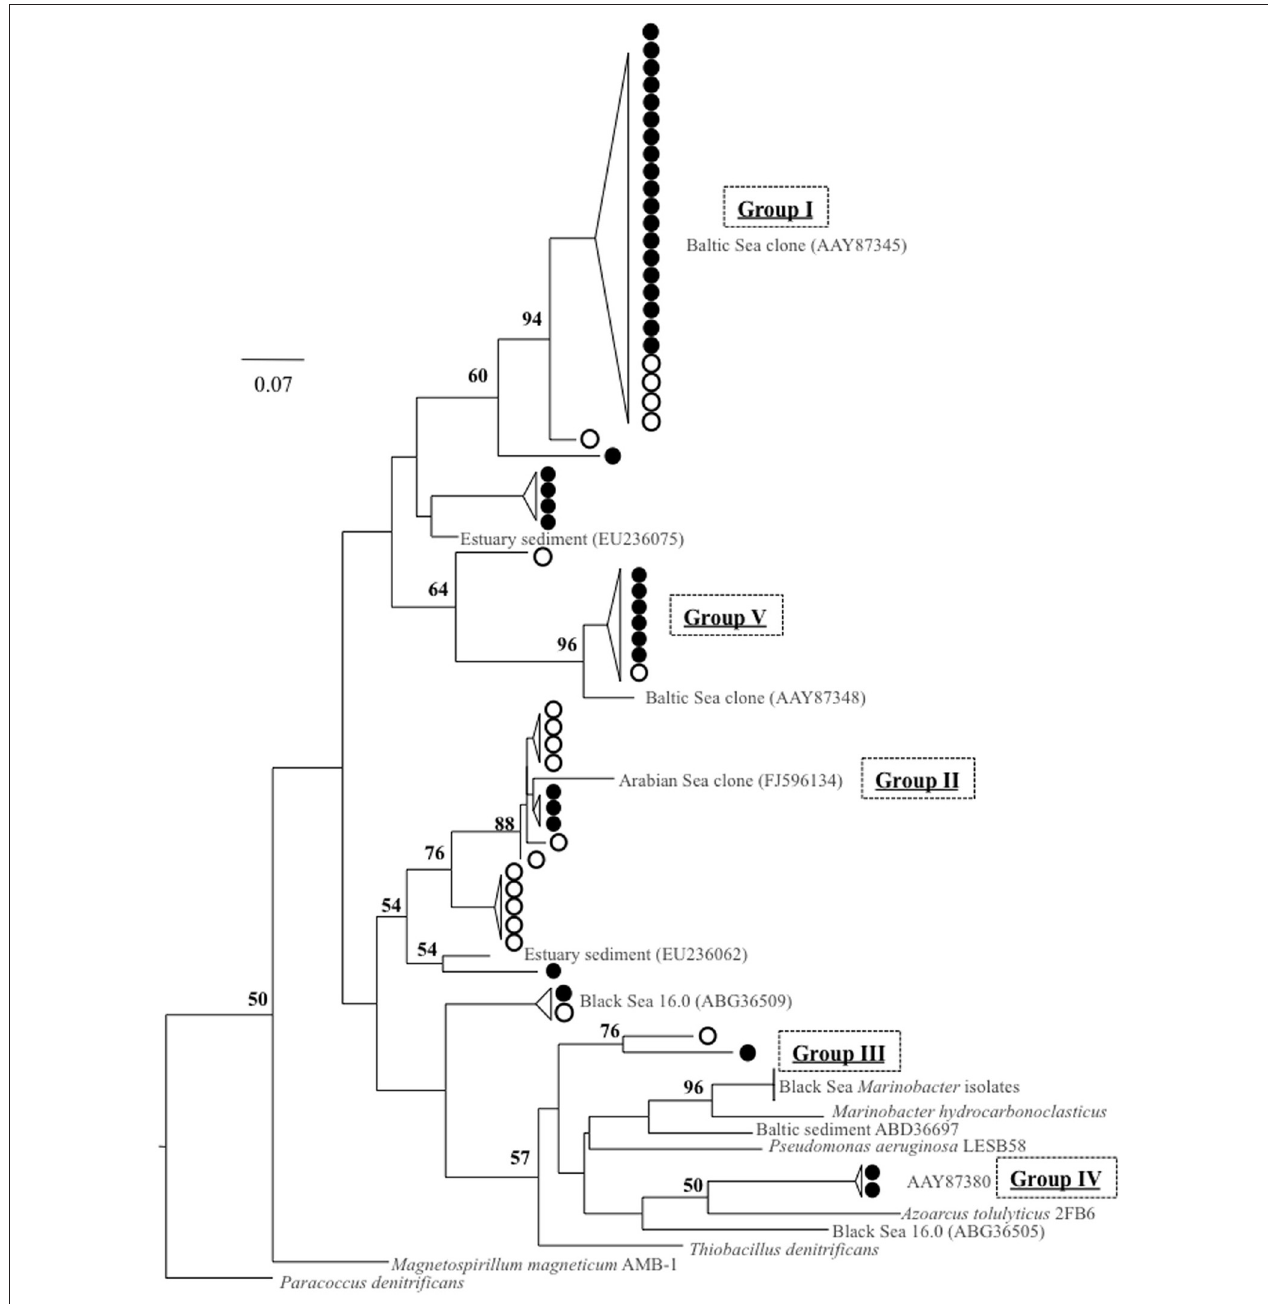
FIGURE 8 | Clone library comparison tree for two different primer pairs: nirS1F/6R, indicated by filled circles, and cd3aF/R3cd, in empty circles. All are from October 2007, σ θ = 16 . 0 or 16.2. References, in gray, include cultured strains (in italics), Baltic Sea environmental clones (Hannig et al.,